Question: Express in one sentence what the figure is showing.
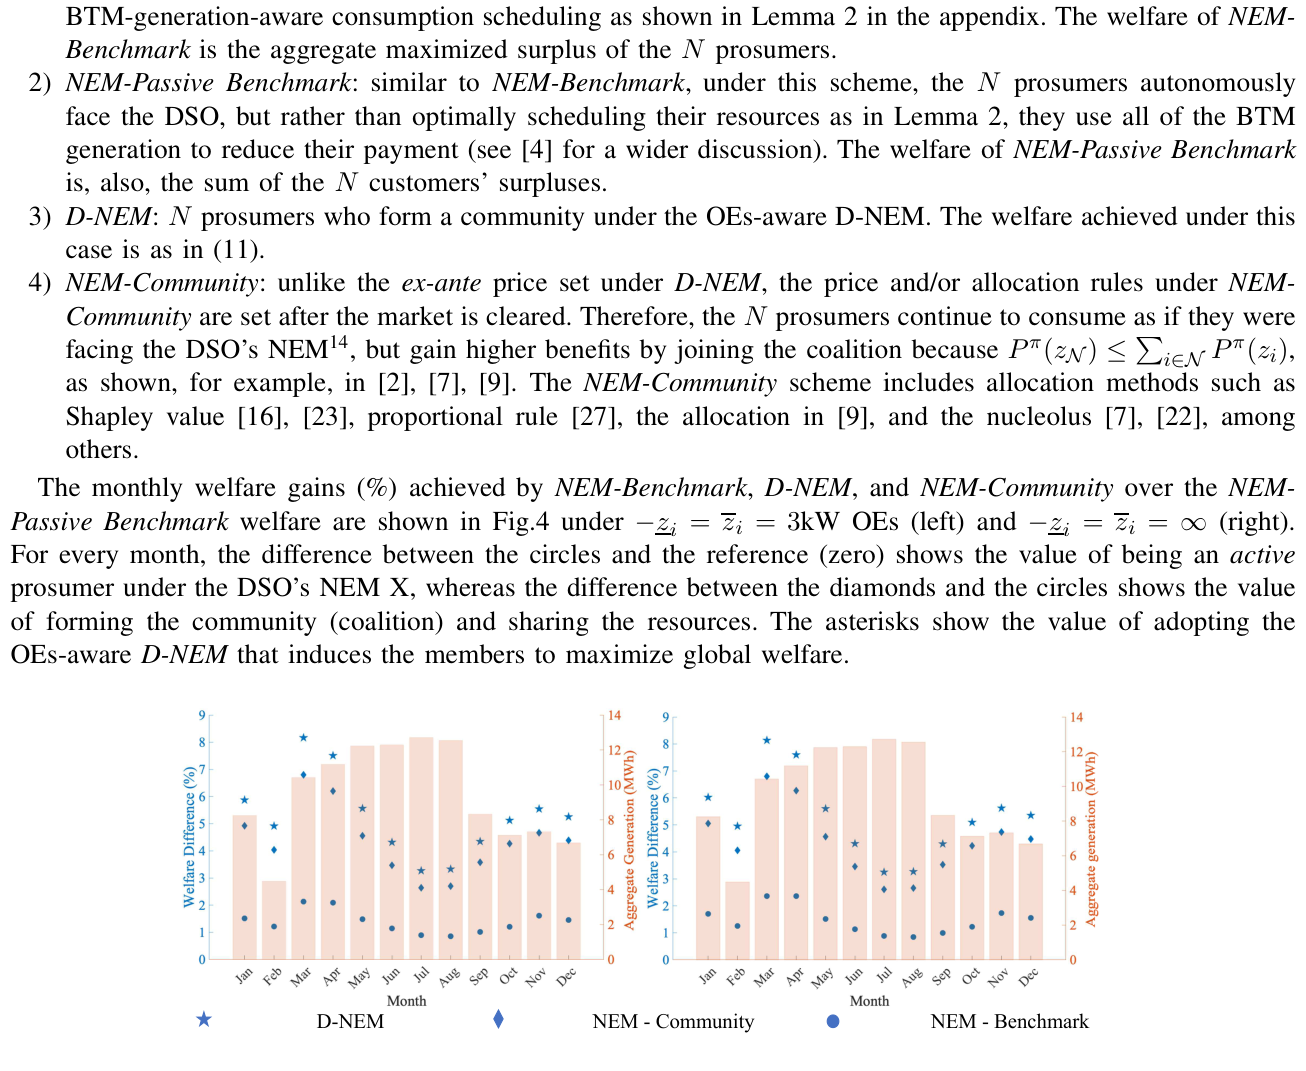
Answer: Monthly welfare gain (%) over NEM - Passive Benchmark under −zi = zi = 3kW (left) and −zi = zi = ∞(right). The bar chart shows the aggregate community generation bN .